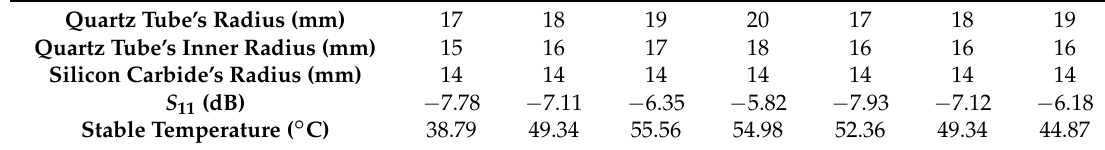
Table 4. The S 11 and stable temperature of different quartz tube’s thicknesses.